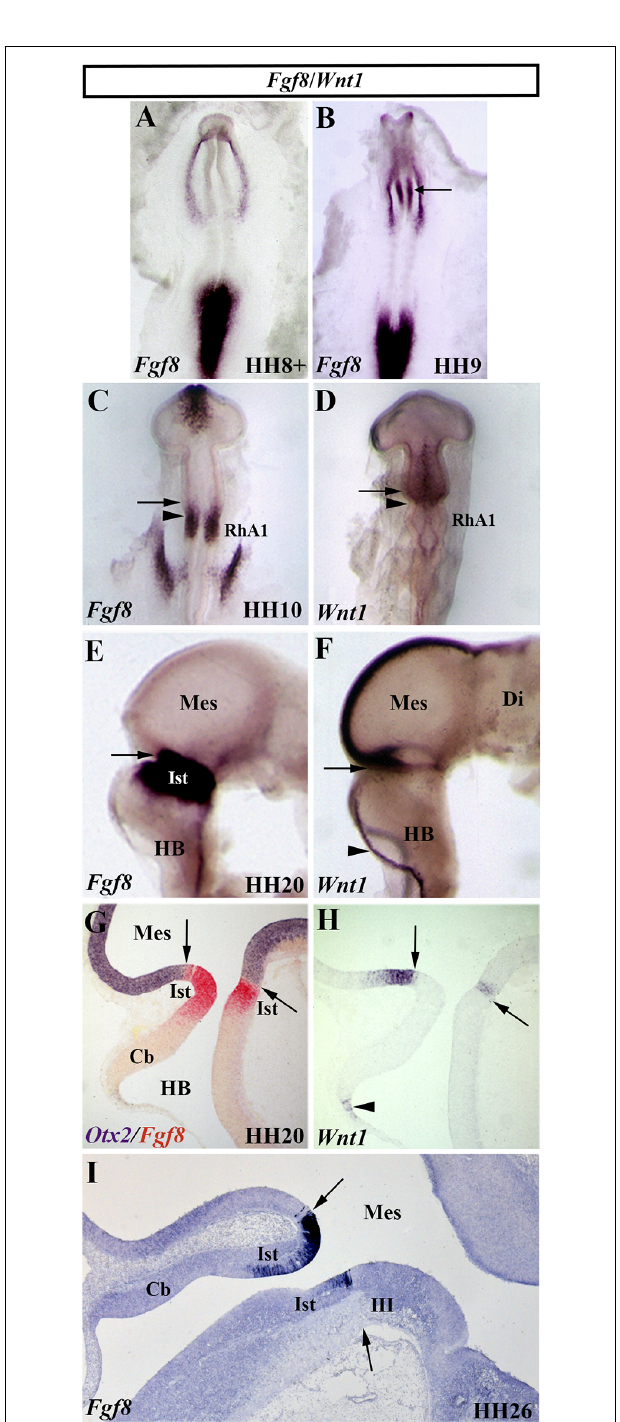
FIGURE 8 | Spatial and temporal expression of Fgf8 and Wnt1 genes in the chick developing MH domain at different developmental stages. Single (A–F,H,I) and double (G) in situ hybridization performed in whole-mount (A–F) and in sagittal sections (G–I) . The arrows point to the Otx2 / Gbx2 MH boundary. In the developing MH domain, Fgf8 transcripts are first detected at stage HH9 ( A ; arrow in B ). At stage HH10, Fgf8 expression is observed in a portion of the neural tube just caudal to the Otx2 / Gbx2